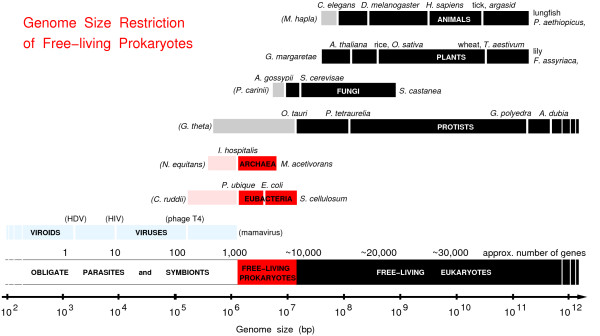
Genome size restriction of free-living prokaryotes. The genomes of free-living prokaryotes (archaea and eubacteria, in red) appear to be restricted to a mere 10-fold range in size from 1.3 Mbp to 13 Mbp, while the sizes of free-living eukaryote genomes (in black) span almost 105 folds from 10 Mbp to near 106 Mbp. The lower ranges of obligate parasite or symbiont genomes, shown as light pink and grey bars, can be much smaller than free-living prokaryote and eukaryote genomes, respectively, due to the progressive loss of dispensable genes. Viruses and gene-free viroids (in light blue) further reduce the size of parasitic "genomes" down to a few hundred nucleotides only.